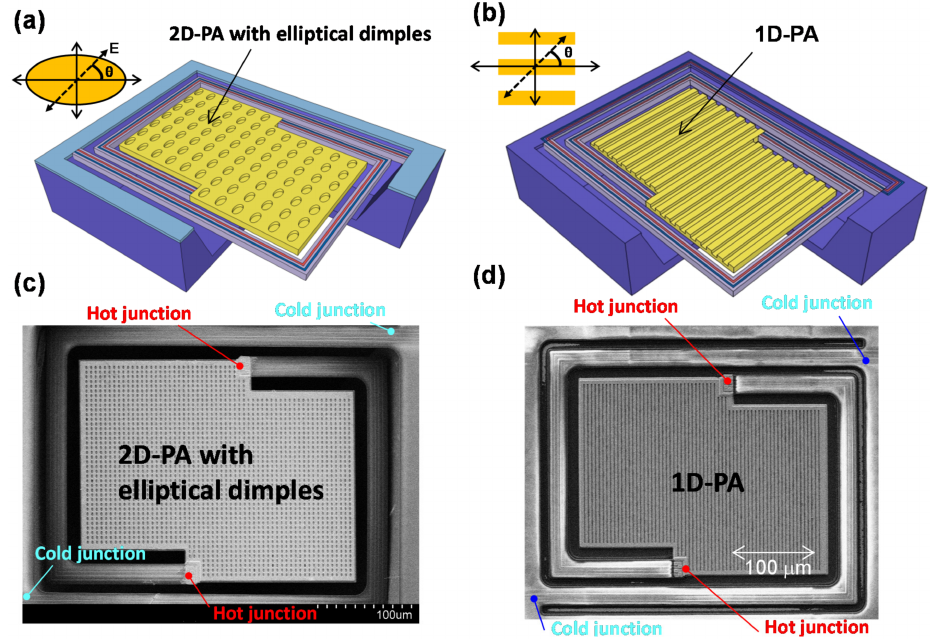
Figure 8. Schematic and SEM images of the uncooled IR sensor (thermopile) using ( a , c ) Au-based 2D-PA with ellipsoidal dimples; and ( b , d ) 1D-PA. The definition of the electric field polarization angle ( θ ) was defined according to the axis of the ellipsoid and the